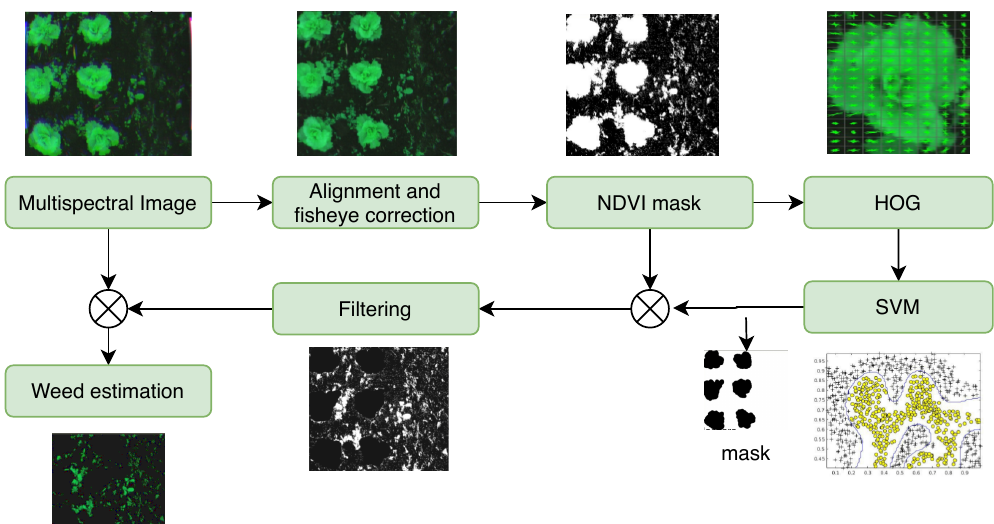
Figure 3. A diagram of method 1 based on HOG (histograms of oriented gradients) and SVM (support vector machines): it shows the sequence of preparation, processing, and weed coverage